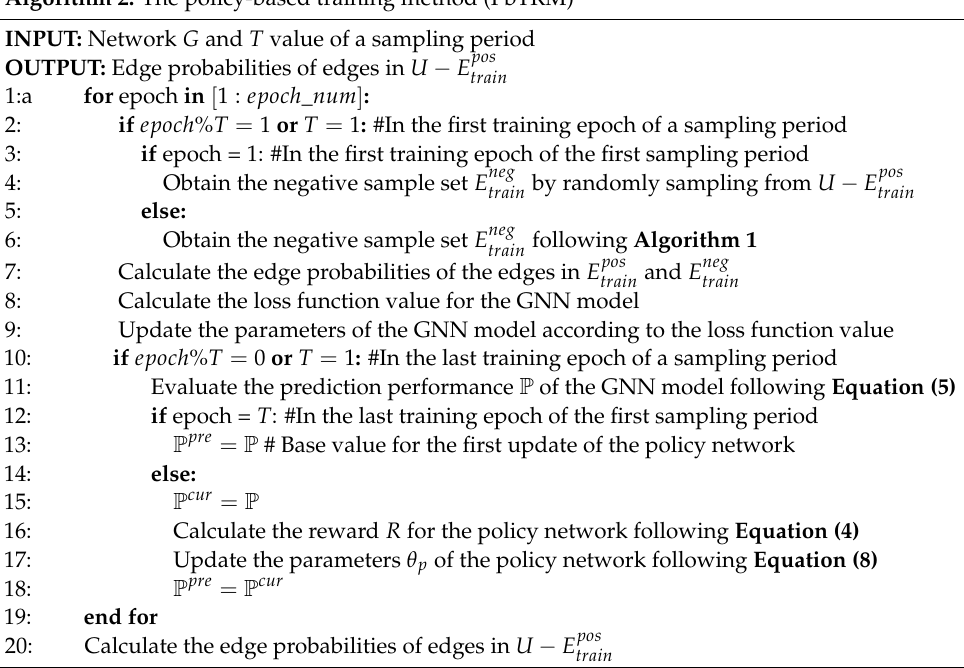
Algorithm 2: The policy-based training method (PbTRM)